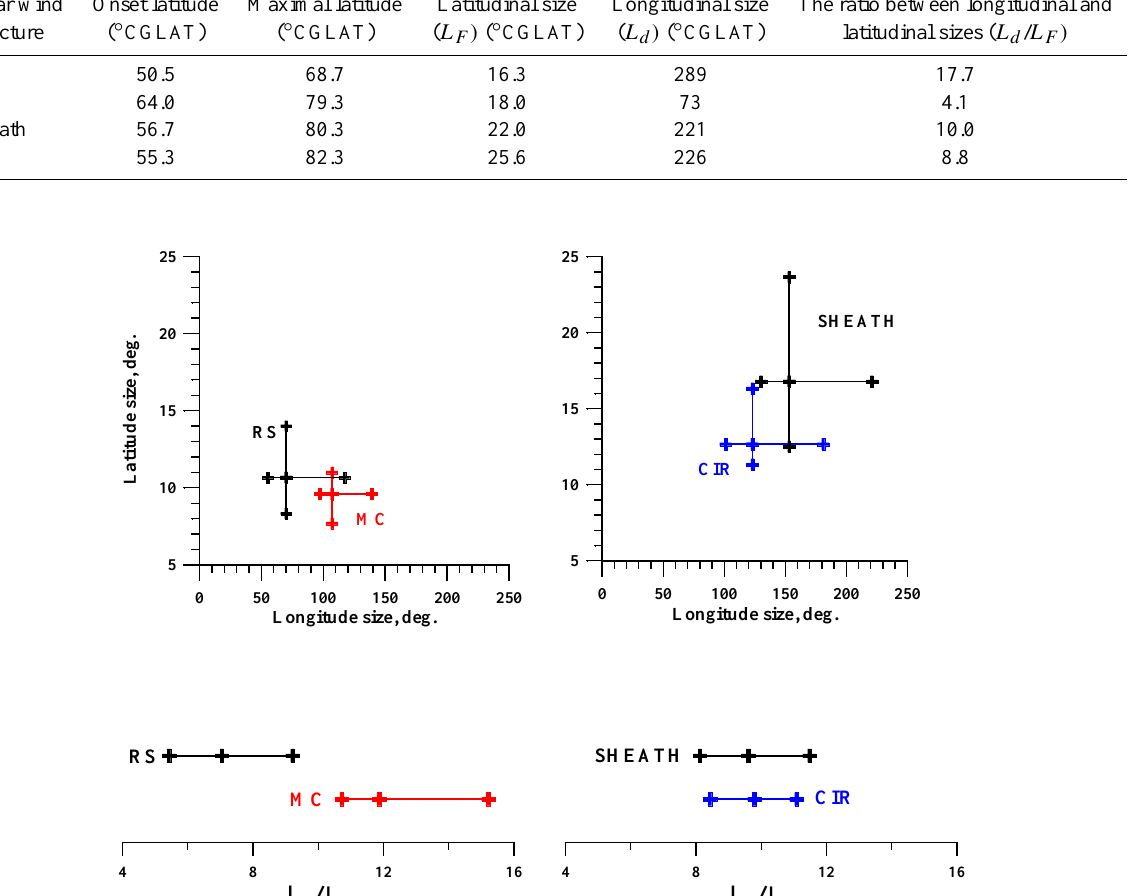
Fig. 4. The median values, first and third quartiles of distribution of auroral bulge parameters for MC and RS (left column), Sheath and CIR (right column). The upper panels show the latitudinal and longitudinal sizes, and the bottom panels present the ratio of longitudinal to latitudinal